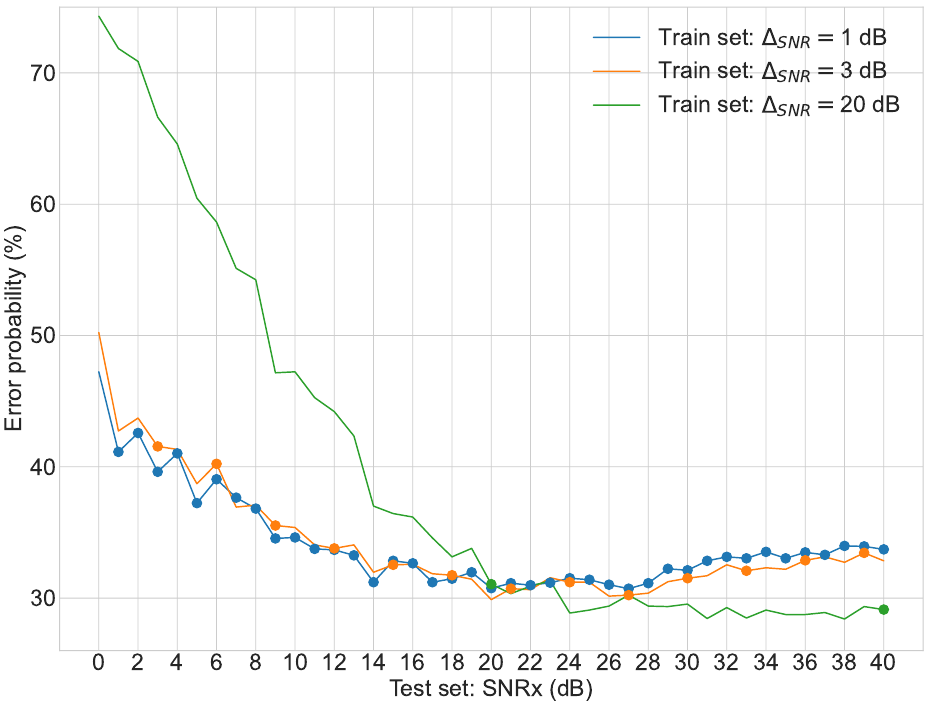
Figure 5. Second stage experiment results: test sets error probabilities for three different models (Reverberated White Gaussian Noise